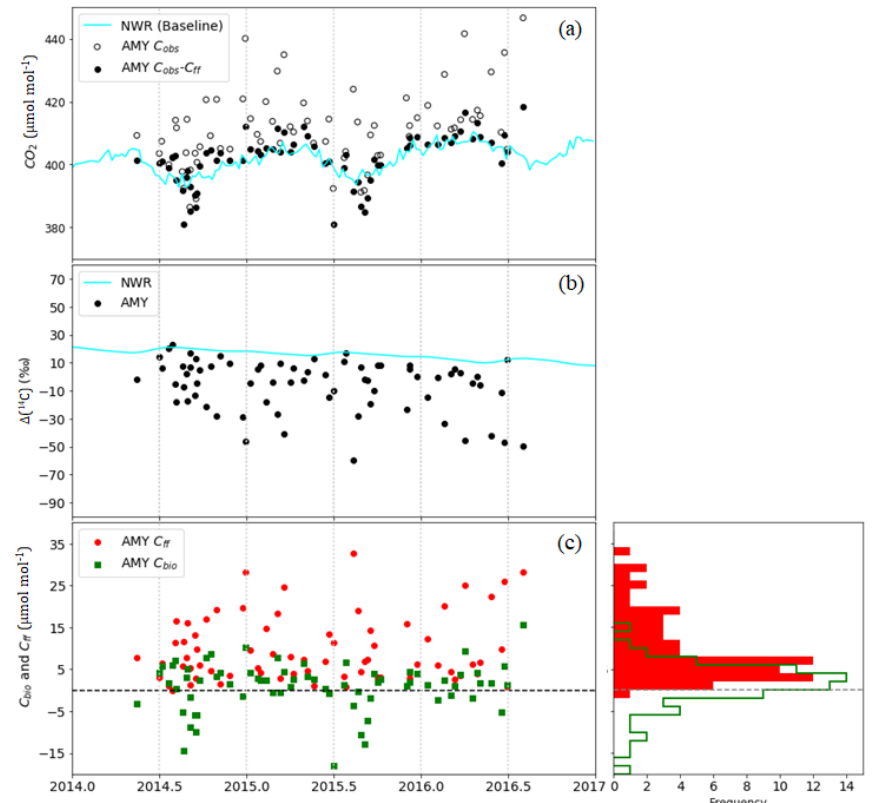
Figure 2. Time series of (a) observed CO 2 dry air mole fraction (open circles) and observed CO 2 ( C obs ) minus C ff calculated from (cid:49)( 14 CO 2 ) (closed circles). (b) (cid:49)( 14 CO 2 ) at AMY (black circles) and at NWR (Niwot Ridge; line), baseline data. (c) Time series of C ff and C bio calculated from (cid:49)( 14 CO 2 ) (left) and the frequency distribution at AMY (right).